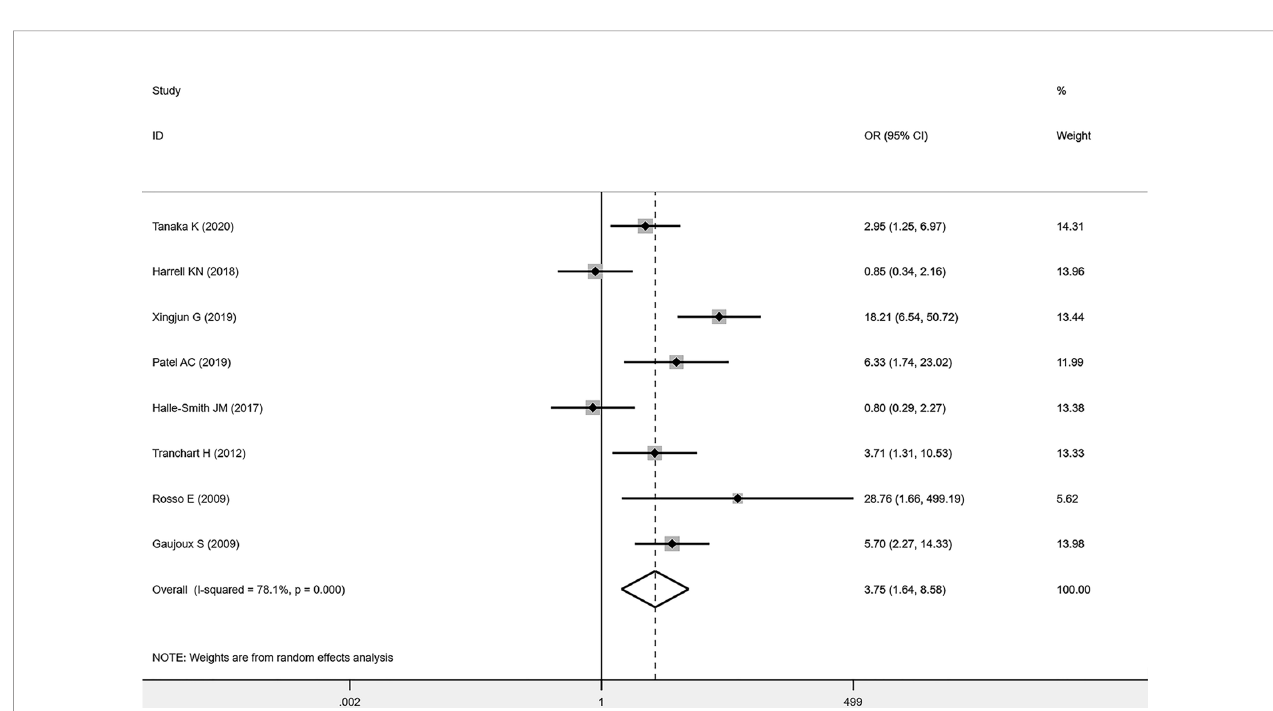
FIGURE 4 | Forest plots of the effect of FP on